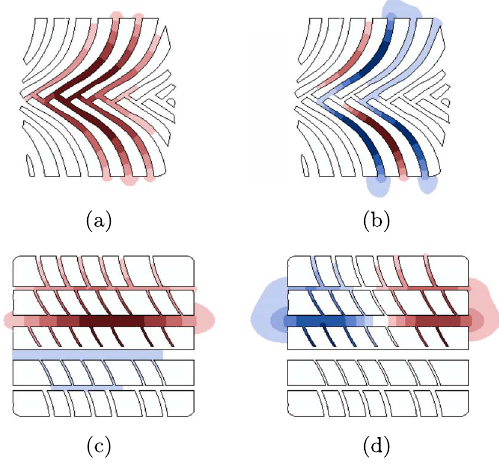
Figure 8. Main resonance shapes computed inside the inner drum test bench with a tire load of 3600